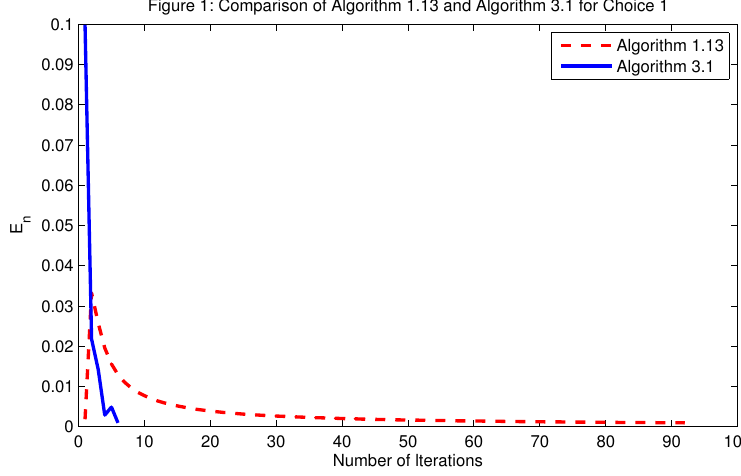
Figure 1: Comparison of Algorithm 1.13 and Algorithm 3.1 for Choice 1